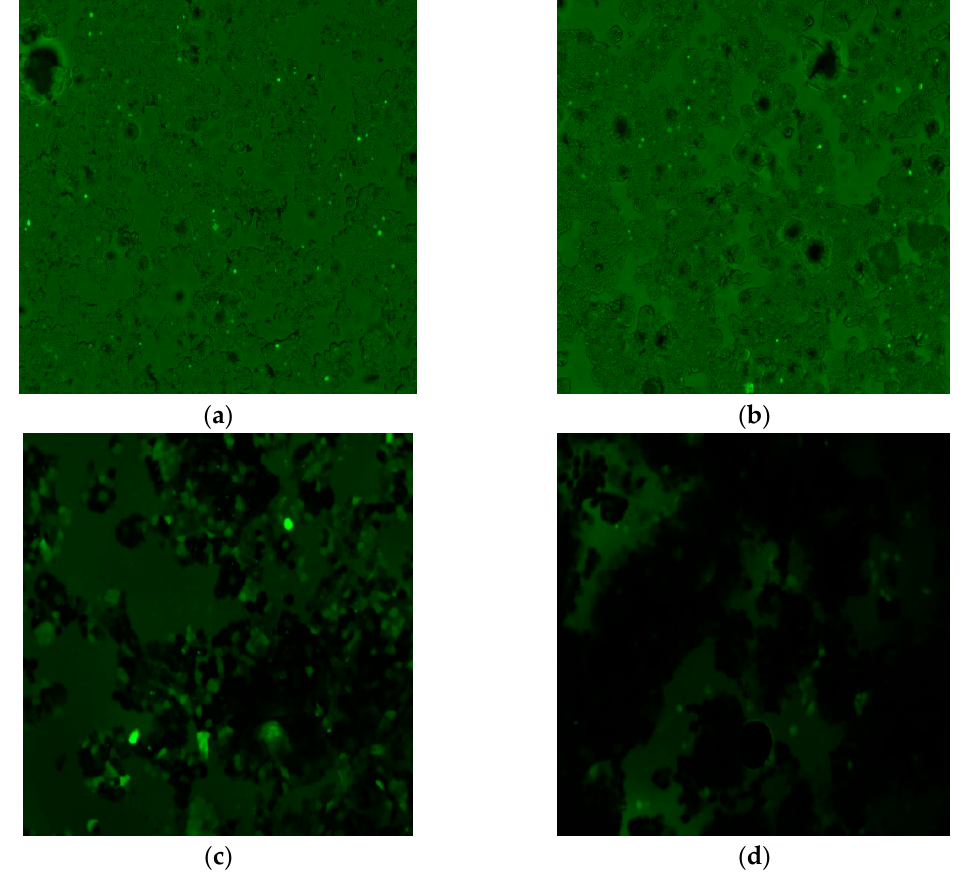
Figure 7. A sequence of microscope images of the HT-29 cells using a green light filter and a blue light source of the labeled samples: ( a ) NC; ( b ) PC; ( c ) DCF H 2 O 2 UMNP; ( d ) DCF UMNP.